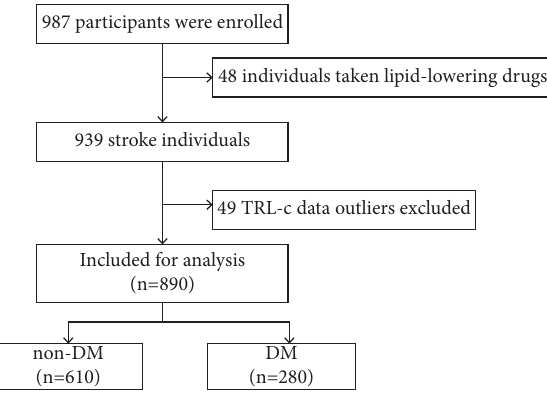
Figure 1: Flow chart of study